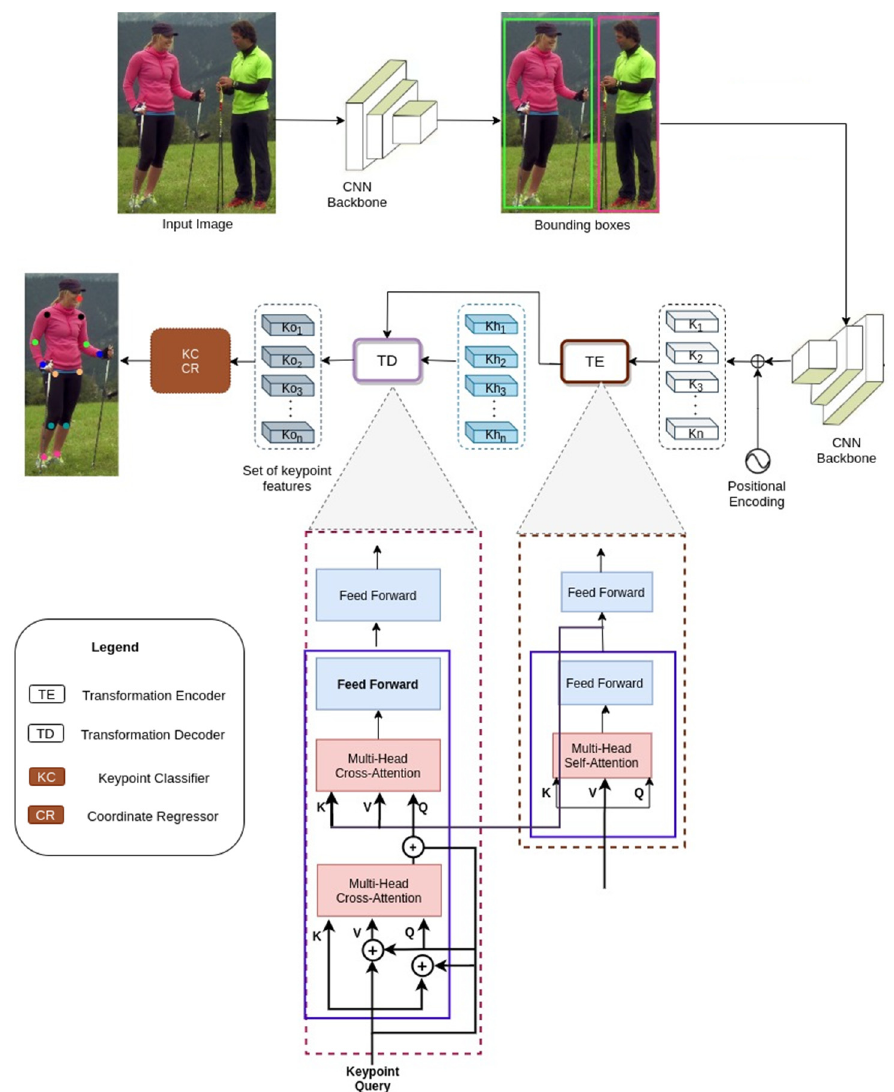
Figure 1. Detailed architectural pipeline of the proposed Cofopose. It starts by extracting and detecting the keypoint positions using the backbone net. Afterwards, the feature map is fed forward. Finally, the feature map is concatenated together with the keypoints so that the encoder can encode their appearances with the 2D locations, and give them as inputs to the transformer decoder in order to predict the human poses.